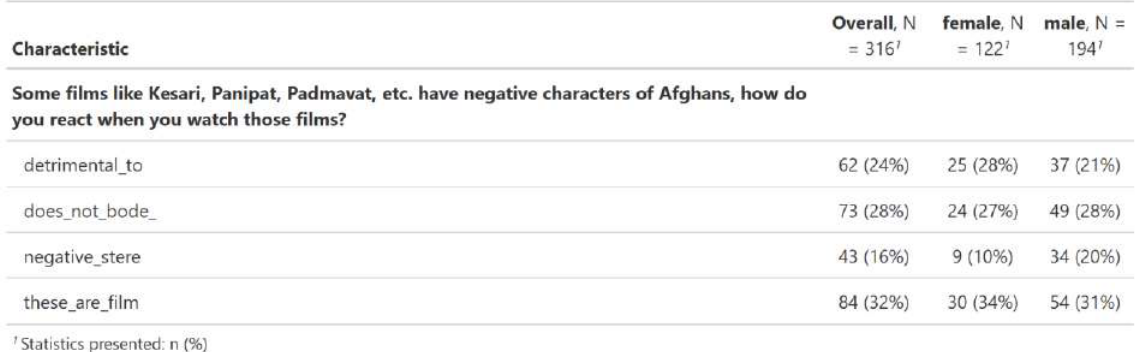
Table 17: Some recent films like „ Kesari ‟ , „ Panipat ‟, „ Padmavat ‟, etc. have negative characters of Afghans. How do you react when you watch those films? ( Source: Authors‟ depiction